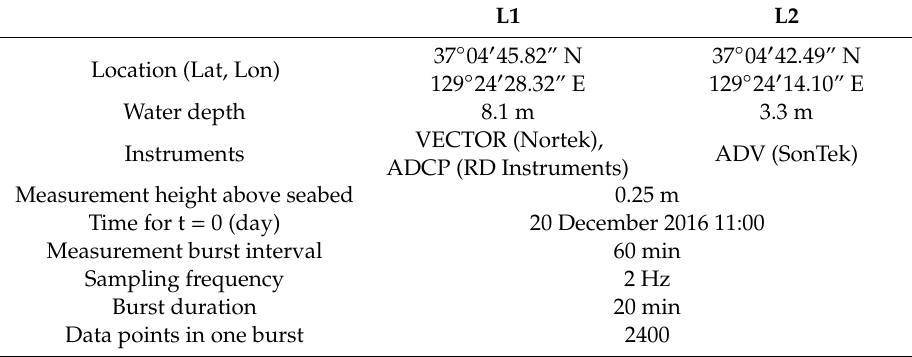
Table 1. Specification of measurements ate L1 and L2 during Exp#1.